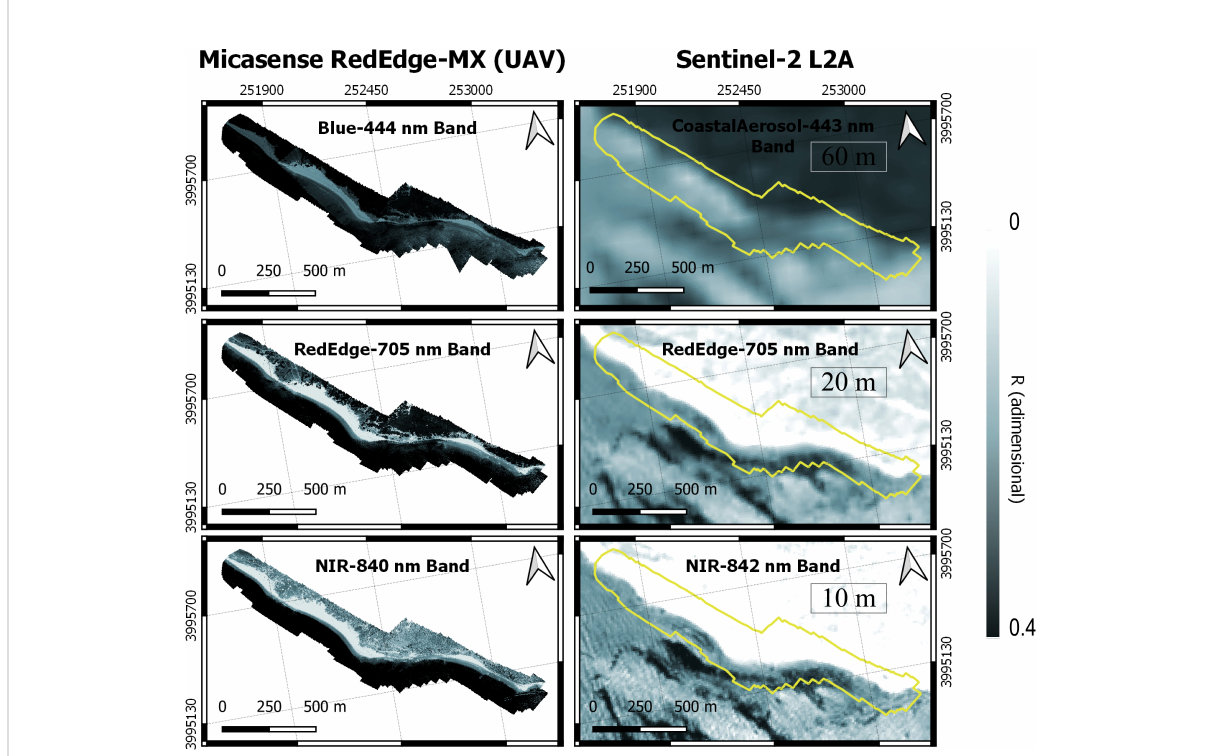
FIGURE 7 Orthomosaic of re fl ectances at different channels for the UAV fl ight (left) and for Sentinel-2 L2A (right) in the study area. Band spatial resolution for S2 channels from 10 to 60 m